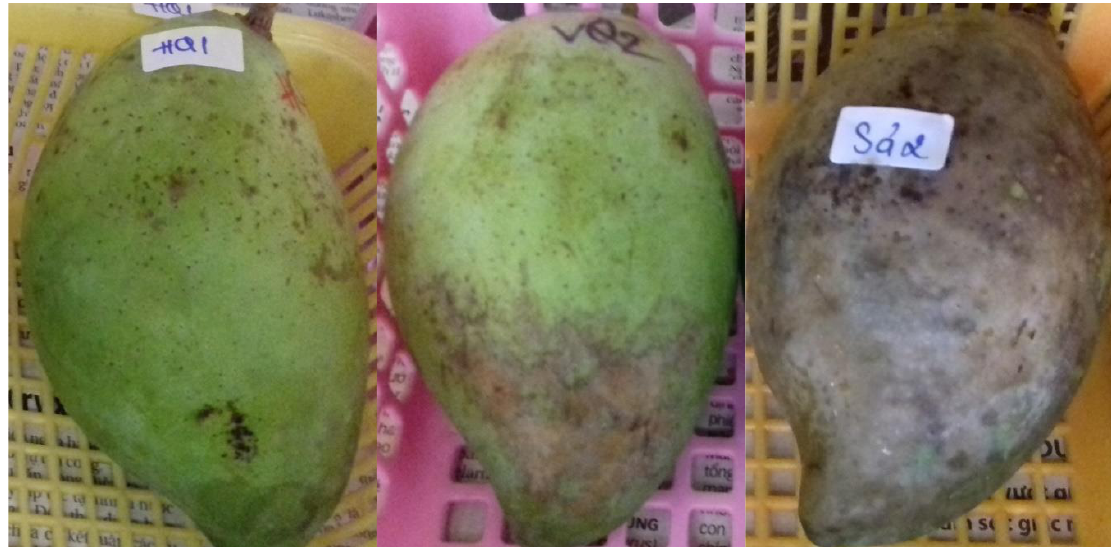
Figure 4. Effect of EOs on the peels of Cat Hoa Loc mango fruits. From left to right: basil, cinnamon, and lemongrass treatment.